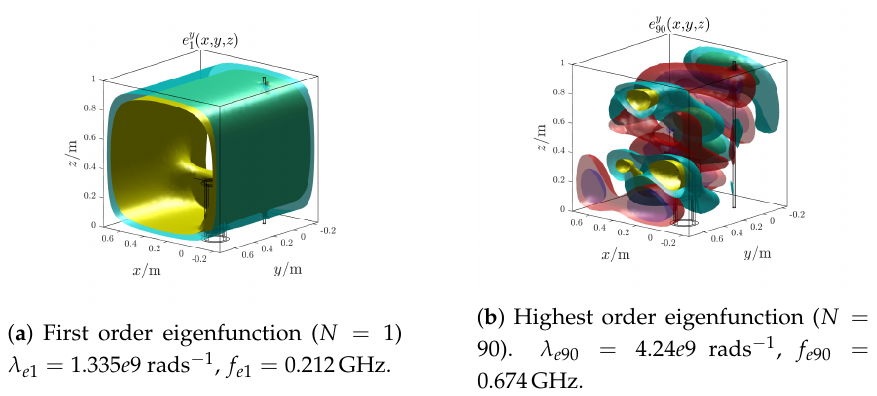
Figure 17. Test case 2. First and highest order electric field eigenfunctions.